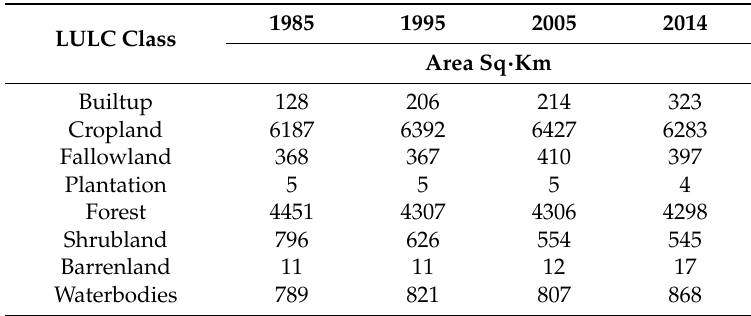
Figure 10. Simulated runoff for the years ( a ) 1985; ( b ) 1995; ( c ) 2005; and ( d ) 2014 for the Pranhita watershed. Table 8. Table showing the eight various LULC categories (in sq·km) of the Pranhita sub-basin of the Godavari River Basin.